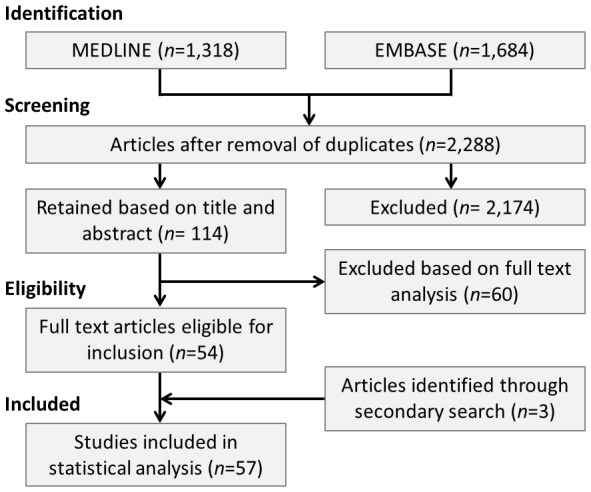
Summary of strategy used to identify studies suitable for analysis.